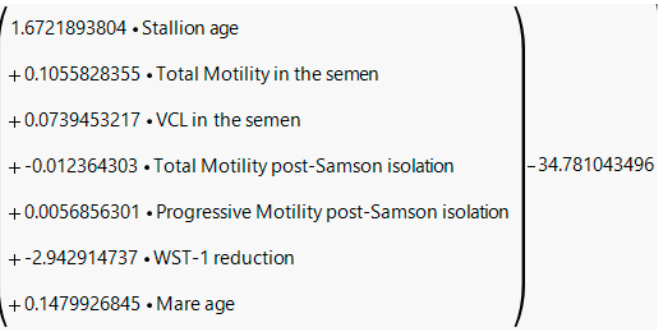
Figure A6. Equation generated when all continuous variables from the post-chilled data set, were made available from all stallions achieving a predictive accuracy for the whole group of 69.6%.